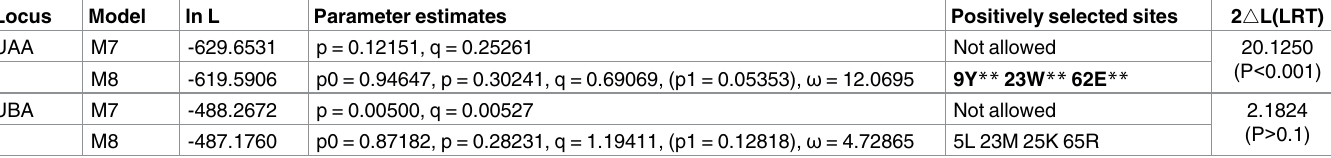
Sites inferred to be under positive selection at the 99% ( ** ) confidence interval level are indicated. lnL, log-likelihood value; ω , selection parameter; p n , proportion of sites that falls into ω n site class. The sites consistent with human PBR site are indicated in bold